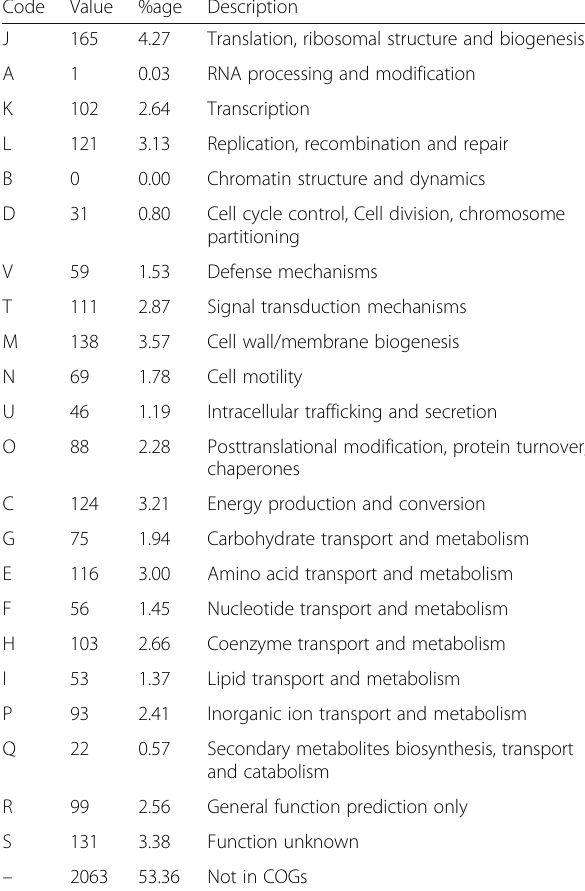
Table 4 Number of genes associated with general COG functional